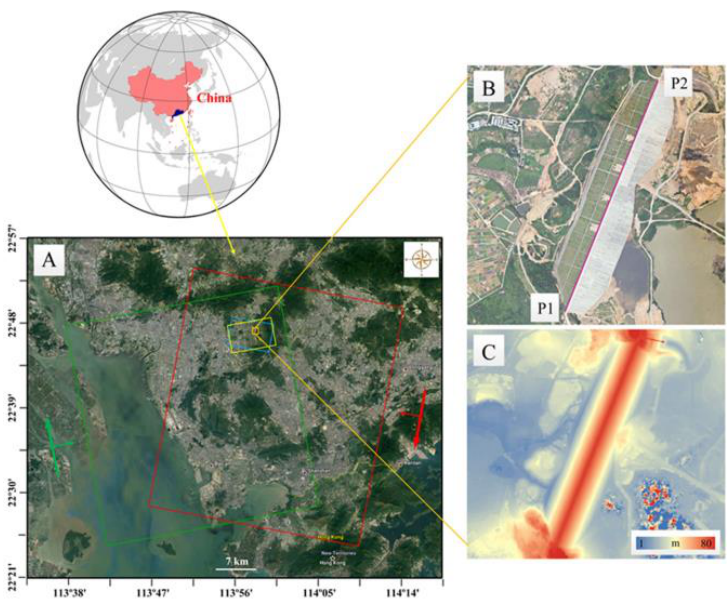
Figure 4. Gongming dam: ( A ) The Google earth image as the background with TSX-SL and CSK-SM images covering the frames; the small orange box represents the number 4 dam; ( B ) an optical image of the number 4 dam taken by Unmanned Aerial Vehicle (UAV) in December 2016, when the main part of the dam construction was complete; P1 and P2 illustrate the dam top; ( C ) the topography of the number 4 dam, produced by the UAV Lidar with a 45 cm resolution in pixels and 20 cm precision in height.